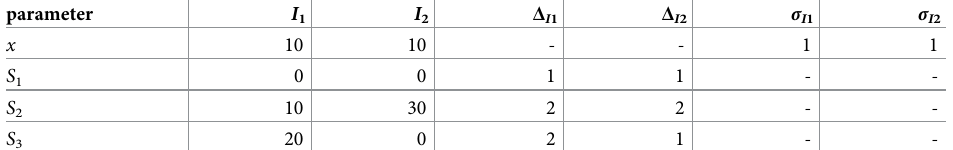
Table 3. Model input parameters for 2D calculations with two isotope signatures I 1 , I 2 and three sources: S 1 , S 2 , S 3 . parameter